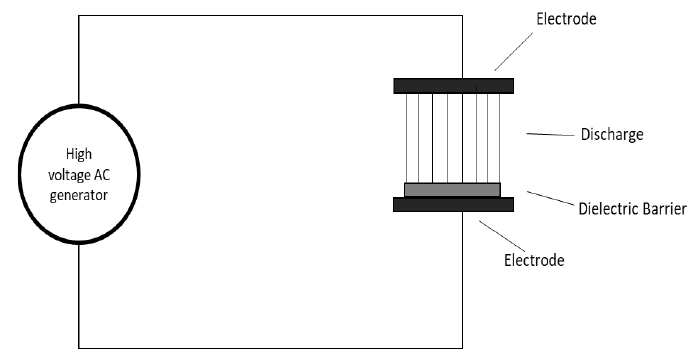
Figure 1. Schematic representation of a